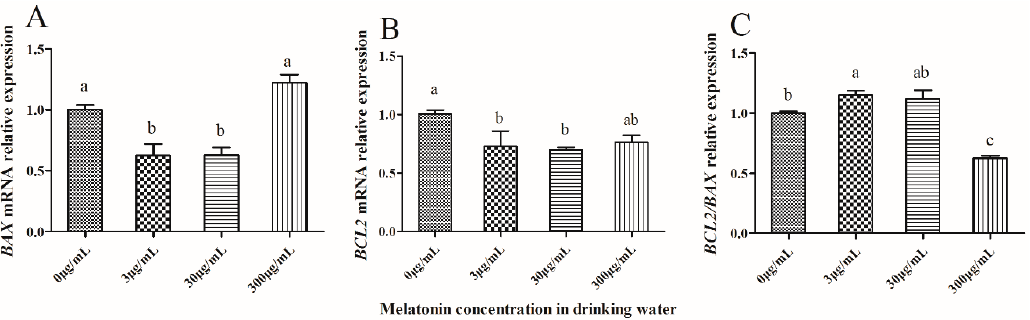
Figure 4. Effect of melatonin on gene expression of mRNA in mouse IVF-derived 2-cell embryos. BAX expression ( A ), BCL 2 expression ( B ) and BCL2/BAX relative expression ( C ) among all groups. The relative expression levels of mRNA were determined by the 2 −ΔΔ CT method and normalized against GAPDH. All data are the mean ± SD from 3 replicates. Different superscripts (a, b) represent treatment differences within panels ( p < 0.05).